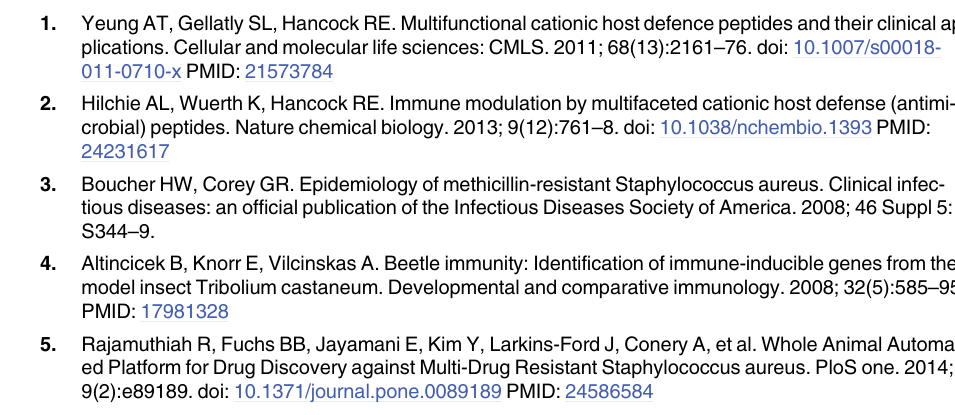
S1 Table. Sixty five insect AMPs synthesized based on publicly available sequence data and tested for antimicrobial properties against MRSA strain